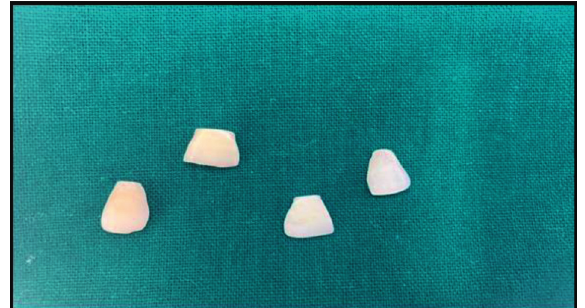
Figure 1: The sample teeth reduced to enamel discs using microtome.